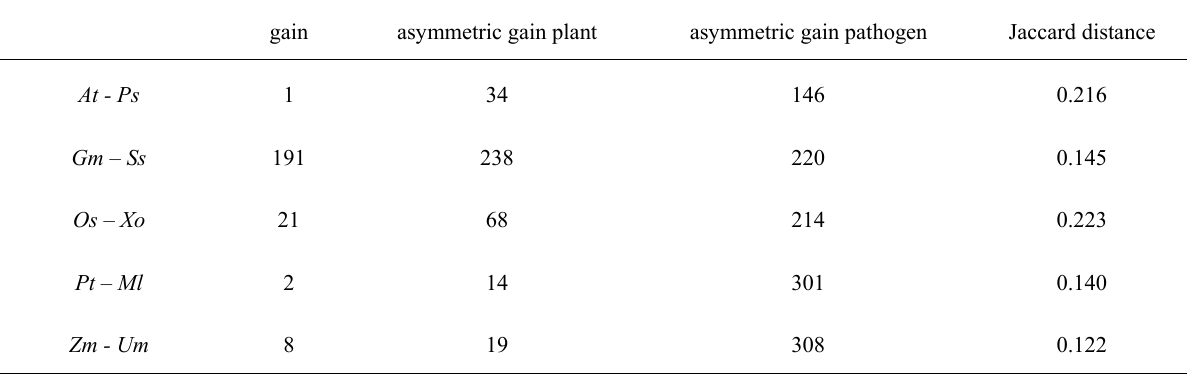
Table 4. Overview of the metabolic gain and Jaccard distance for all five plant-pathogen pairs. gain asymmetric gain plant asymmetric gain